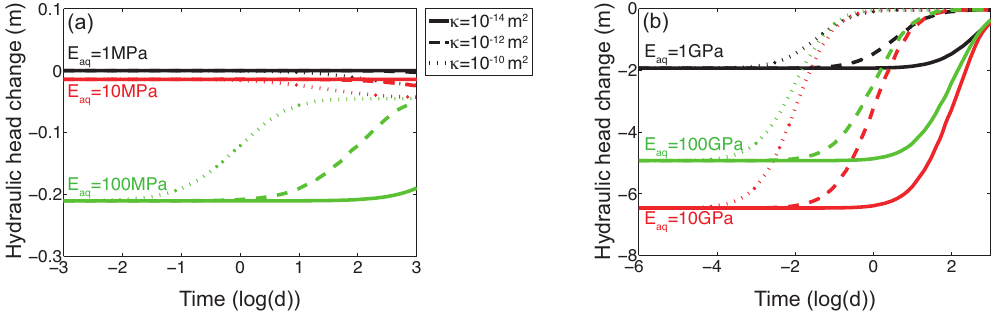
Figure 5. Influence of Young’s modulus and permeability of the aquifer on the central hydraulic head change and its evolution with time. (a) Pyroclastic aquifer, (b) lava flow